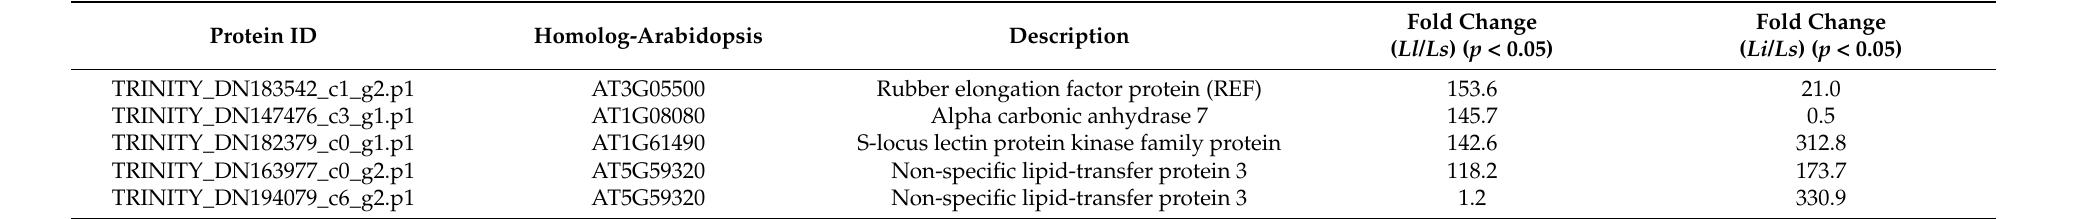
Table 1. Some candidate genes responsible for the biosynthesis of Amaryllidaceae alkaloids in Lycoris